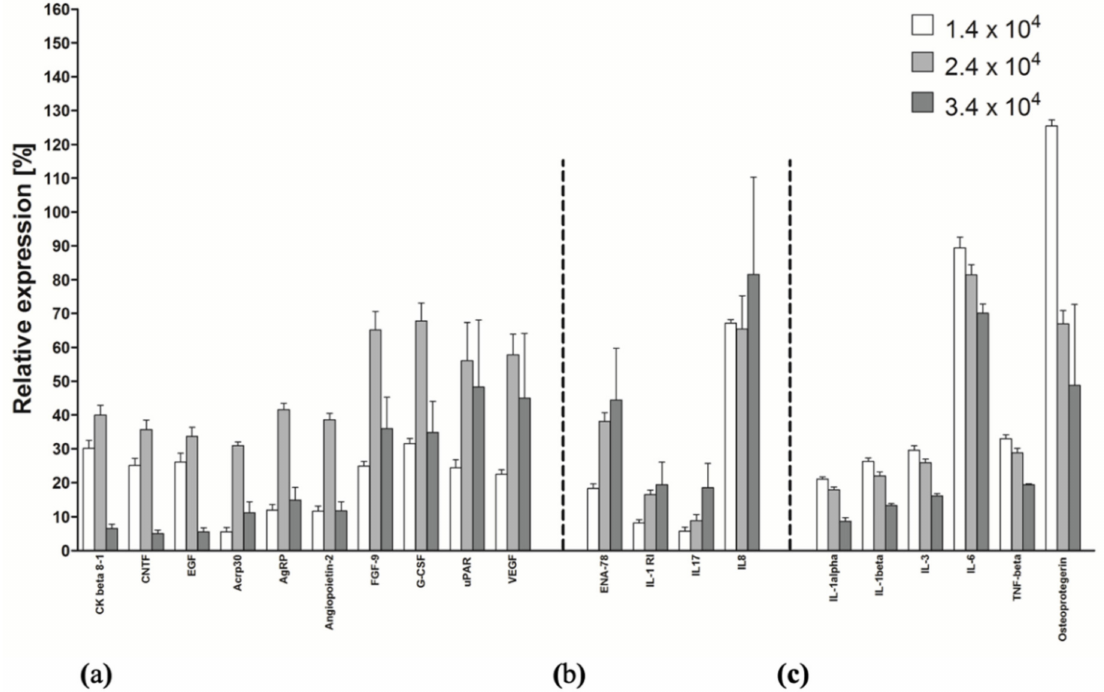
Figure 5. Selected cytokine production as a function of the initial cell culture density. ( a ) Factors produced most effectively by intermediate density cultures. ( b ) Factors produced most effectively by high density cultures. ( c ) Factors produced most effectively by low density